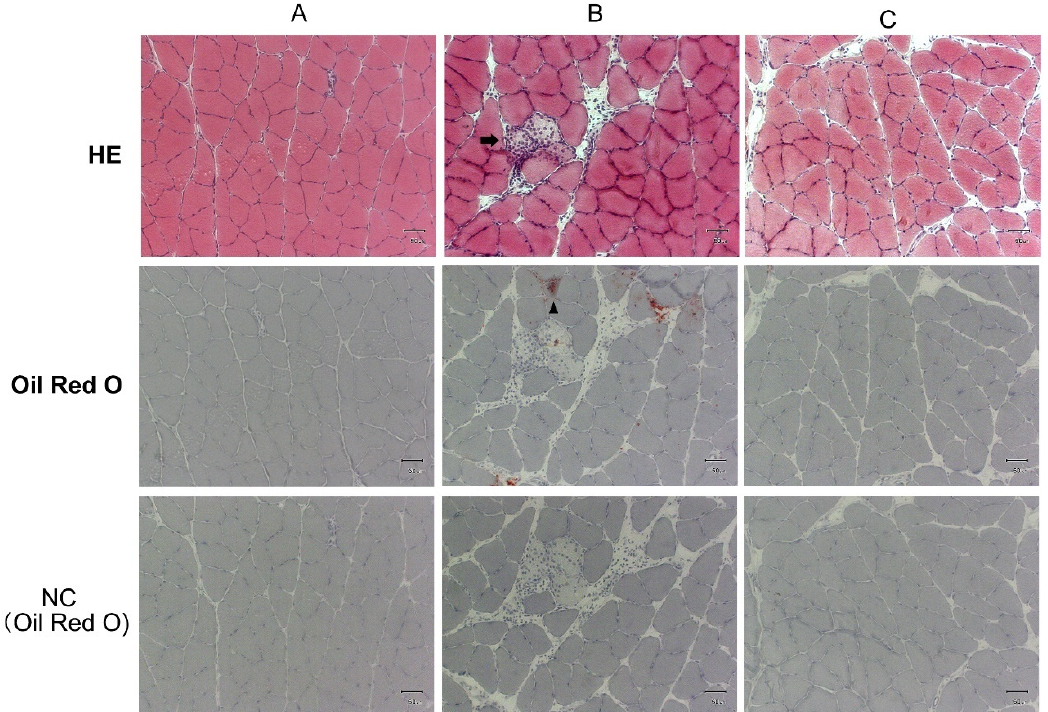
Figure 8. Long-term supplementation of acetic acid attenuates lipid accumulation and fibrosis in the soleus muscles of SD rats at 56 weeks of age. ( A ) SD rats at 20 weeks of age; ( B ) SD rats of the water group at 56 weeks of age; ( C ) SD rats of the acetic acid group at 56 weeks of age. HE: hematoxylin and eosin stain; Oil red O: Oil red O stain; NC: Before Oil red O stain; subjected to ethanol treatment with the subsequent removal of lipids. Arrowhead: lipid accumulation; arrow: necrosis. Scale bar: 50 μ m.